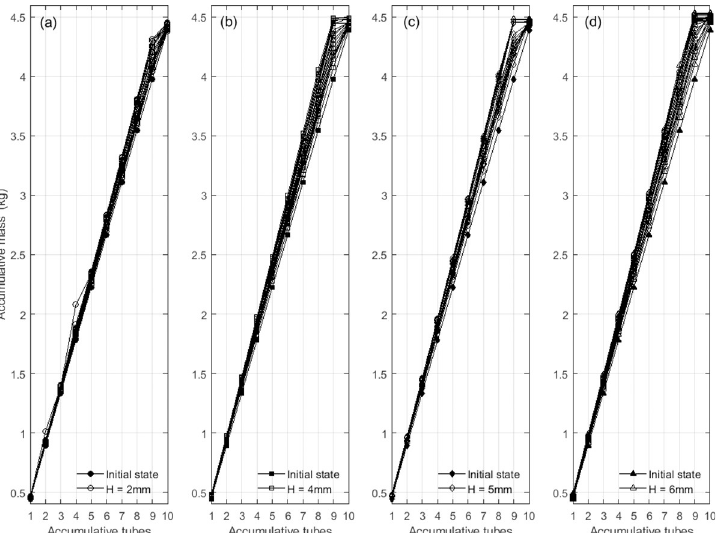
Fig 8. The accumulative mass distributions of compacted soil at different drop height. H : H = 2 mm (a), H = 4 mm (b), H = 5 mm (c) and H = 6 mm (d). The lines within each panel correspond to the 20 measurements of the local packing density.